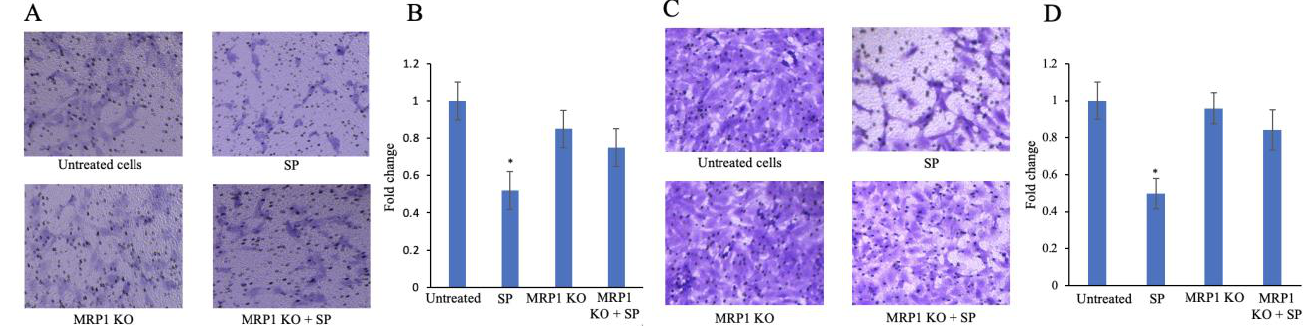
Figure 6. Effect of ABCC1 knockout on migration and invasion in Swan-71 cells exposed to palmitic acid. Migration ( A ) and invasion ( C ) in Swan-71 ABCC1 knockout and wild-type cells with or without exposure to palmitic acid. Images were captured from the underside of the transwell inserts. Quantification ( B , D ) was carried out by counting the migrated or invaded cells using a hemocytometer. Mean values were obtained from three independent experiments and error bars represent SD. * p <